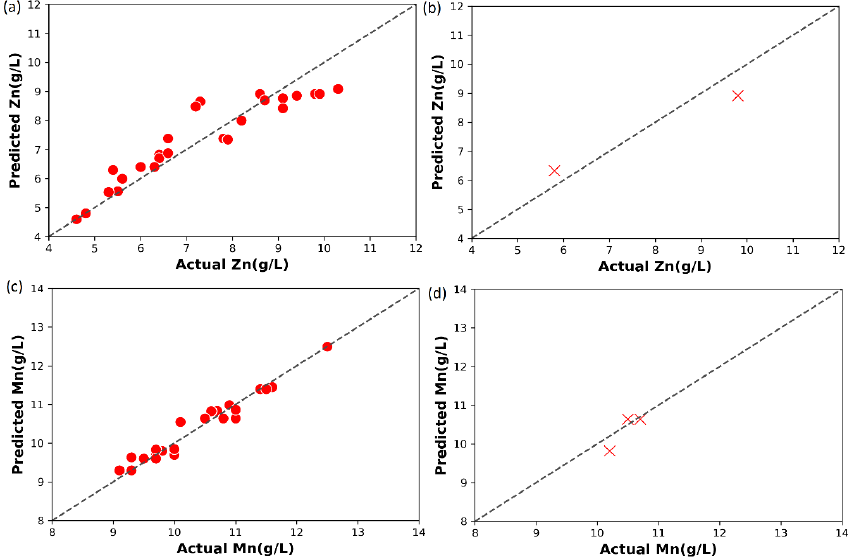
Figure 8. Actual versus AdaBoost regression-based predicted ( a ) Zn (g/L) training, ( b ) Zn (g/L) test- ing, ( c ) Mn (g/L) training and ( d ) Mn (g/L) testing data.